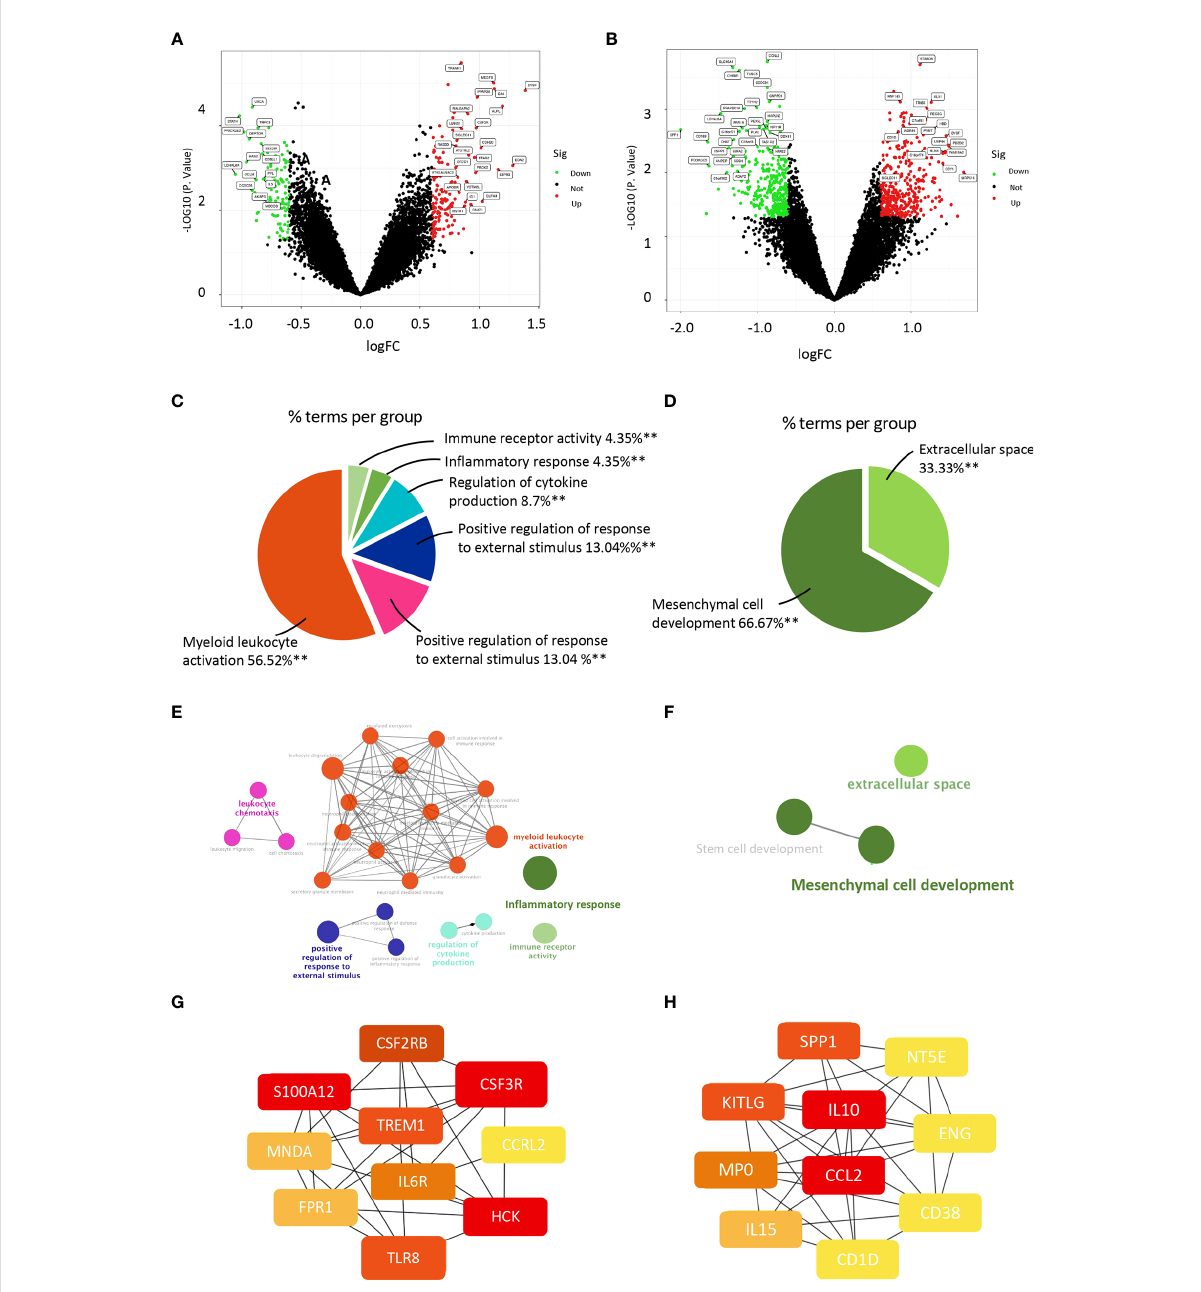
FIGURE 2 ClueGO enrichment analysis of DEGs and construction of PPI networks in PCOS with different androgen levels. (A) Volcano map of DEGs in the HA PCOS group and the control group. The green dots represent low expression, and the red dots represent high expression. (B) Volcano map of DEGs in the NHA PCOS group and the control group. The green dots represent low expression, and the red dots represent high expression. (C) Pie chart shows the proportion of each GO terms in HA PCOS group. (D) Pie chart presents the proportion of GO terms in NHA PCOS group. (E) The interaction network of GO terms in HA PCOS group presented by the Cytoscape plug-in ClueGO. The most signi fi cant term in each group is highlighted. (F) The interaction network of GO terms in NHA PCOS group presented by the Cytoscape plug-in ClueGO. The most signi fi cant term in each group is highlighted. (G) The top 10 hub genes ranked by degree in the PPI network of HA PCOS. (H) The top 10 hub genes ranked by degree in the PPI network of NHA PCOS. ** P <